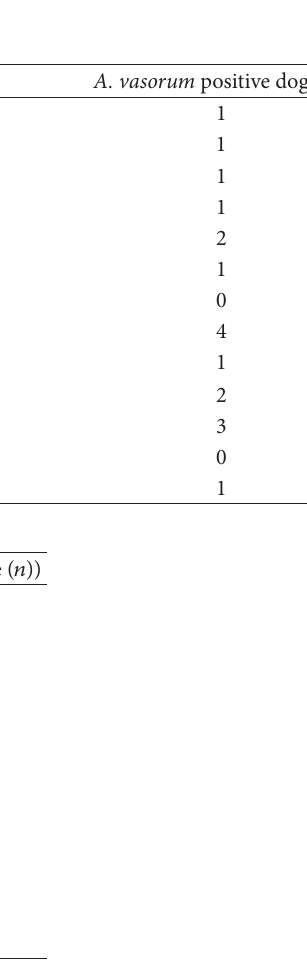
Table 1: (a) Clinicopathological changes indicating potential infections with Angiostrongylus vasorum in a random dog population (𝑛 = 210) and the corresponding number of dogs confirmed by faecal Baermann examination; (b) scoring of dogs with clinico-pathological changes indicating potential infections with Angiostrongylus vasorum in a random dog population (𝑛 = 210) and the corresponding number of dogs confirmed by faecal Baermann